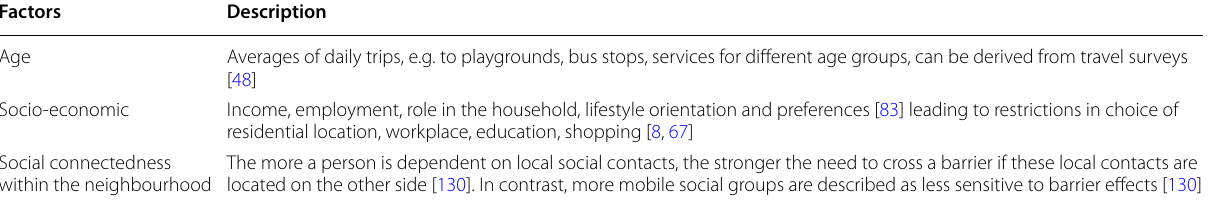
Table 5 Factors that influence people’s needs to visit destinations involving trips across or along a barrier Factors